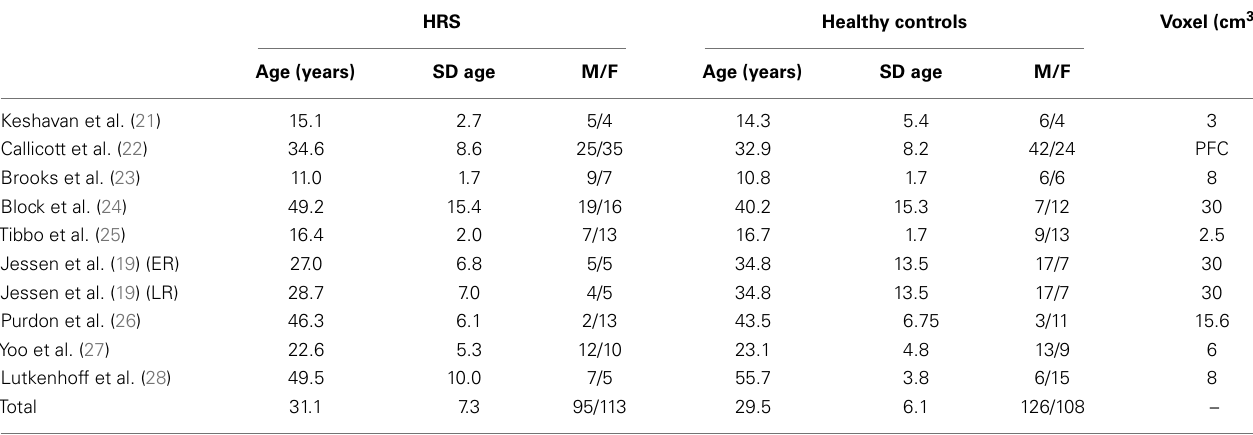
Table 1 | Characteristics of studies included in the